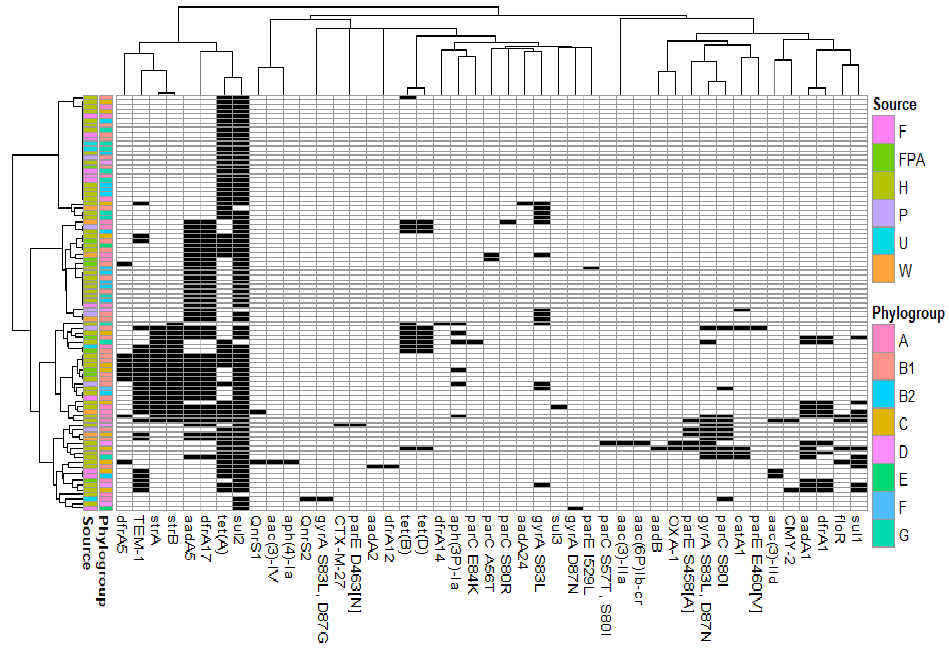
Figure 3. Antimicrobial resistance mechanisms associated with non-redundant E. coli harbouring bla CTX-M-1 and IncI1-ST3 bla CTX-M-1 and IncI1-ST3 plasmids (black: presence; white: absence). Source: F, food; FPA, food- plasmids (black: presence; white: absence). Source: F, food; FPA, food-producing animals; H, human; P, pet; U: unknown and W, wild animal. producing animals; H, human; P, pet; U: unknown and W, wild